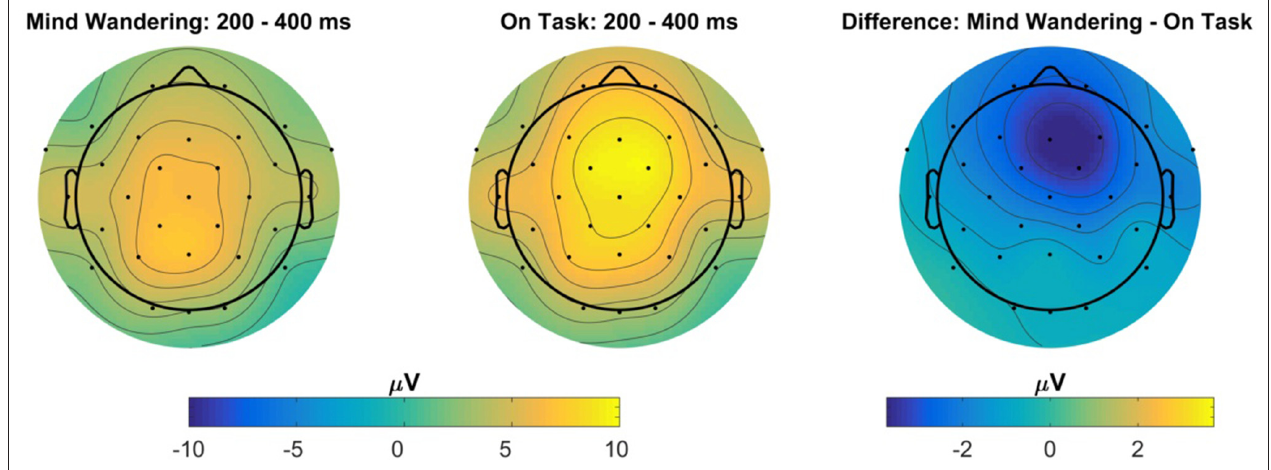
FIGURE 11 | Topography of the ERP to the auditory probe tone, for “mind wandering” vs. “on task” responses, averaged within the 200–400 ms P3a window following probe onset, collapsed across all days and drives. The right-most panel represents the topography of the difference between “mind wandering” and “on task”